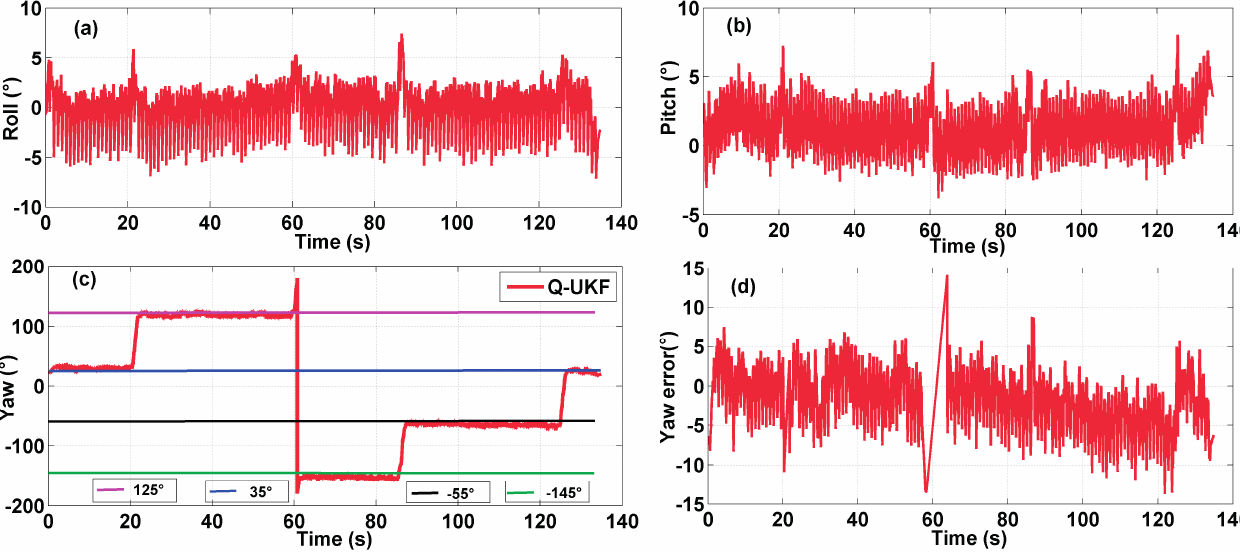
Figure 8. Multi-sensor system on waist of a pedestrian test: ( a ) roll angle; ( b ) pitch angle; ( c ) yaw angle; ( d ) yaw angle